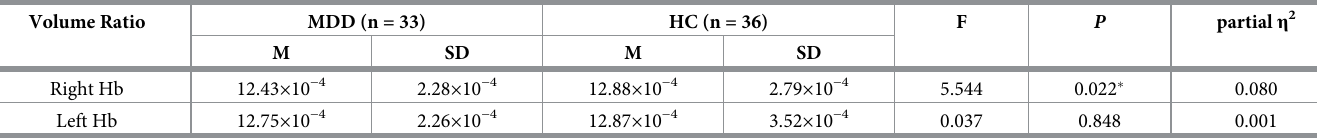
Table 2. Comparison of the normalized habenula volume between the MDD and HC groups, controlling for potential confounders. Volume Ratio